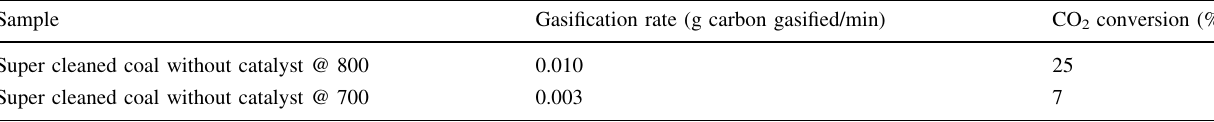
Table 5 Carbon conversion (Gasification rate) and CO 2 conversion during CO 2 gasification